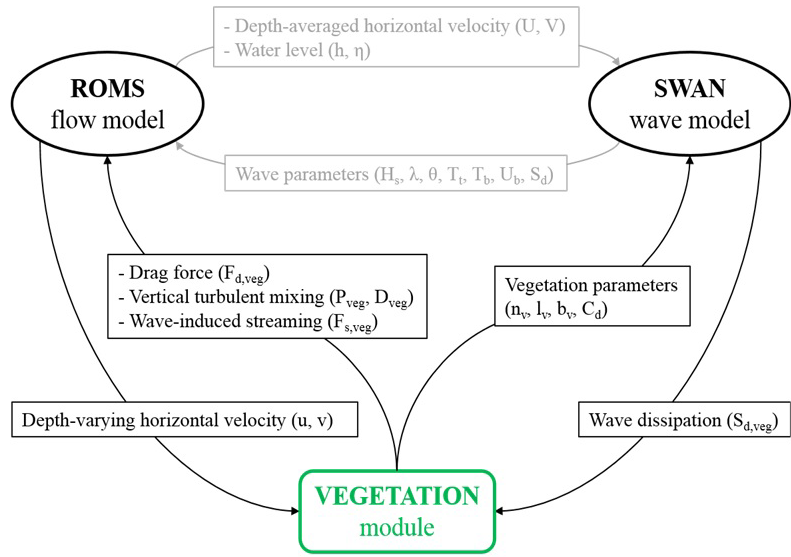
Figure 1. Schematic showing the vegetation module implementation in the COAWST model (figure adapted from Beudin et. al,